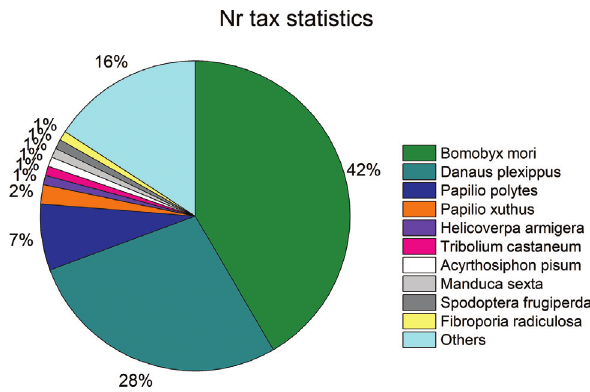
Figure 4 - KEGG biochemical maps for Lymantria dispar .